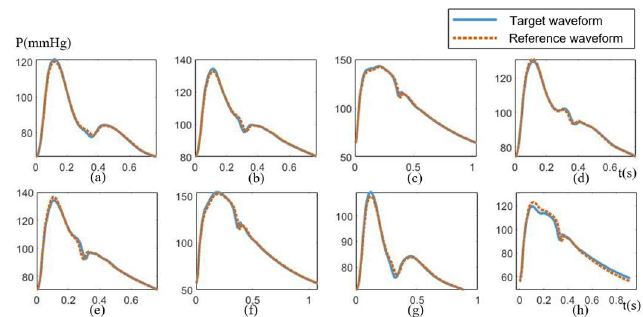
Figure 9. Reference waveforms match well with targeted waveforms. ( a – h ) 8 groups selected ran- domly comparing the recognized reference waveforms and matching well with the target waveforms.